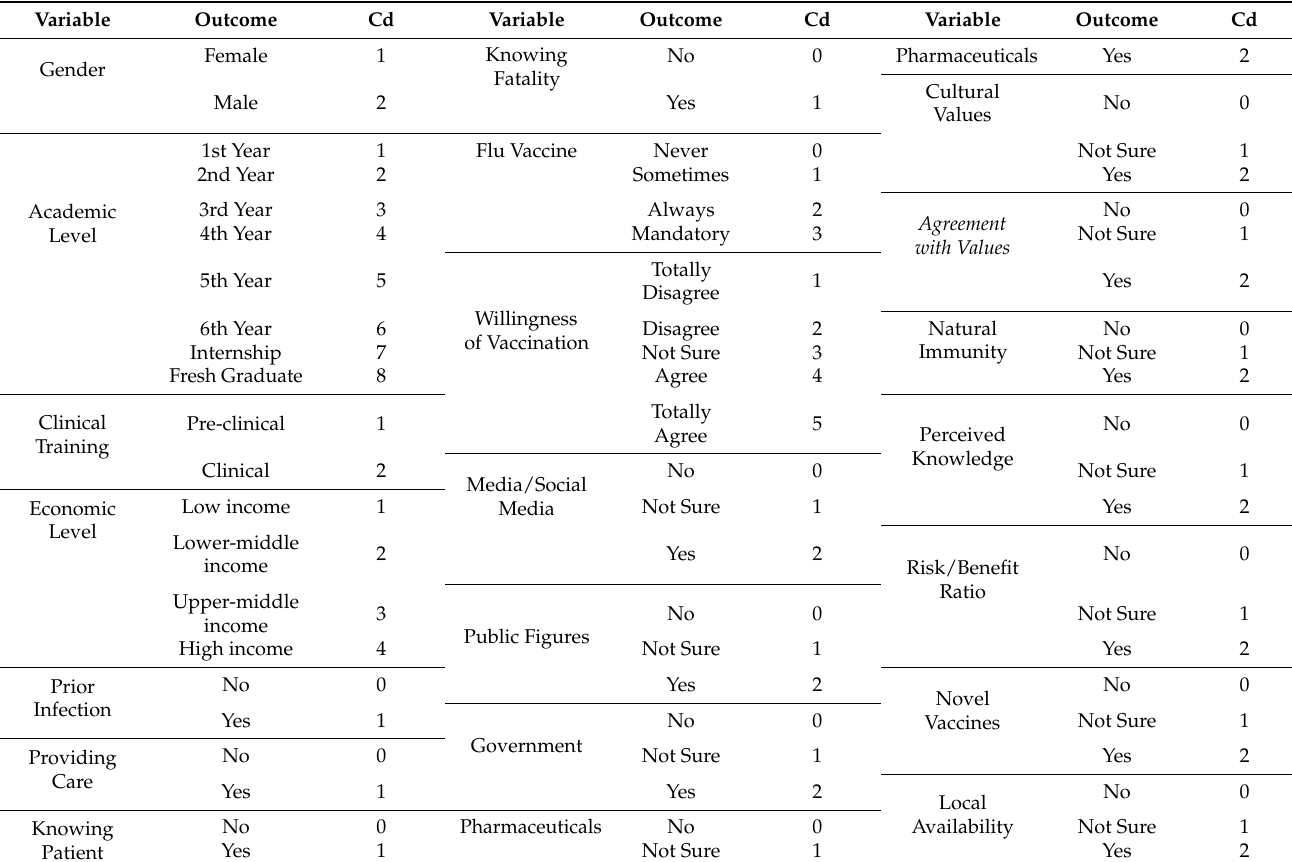
Table 2. The enhanced dataset of dental students’ COVID-19 vaccine-related attitudes, February 2021 ( n = 6639).